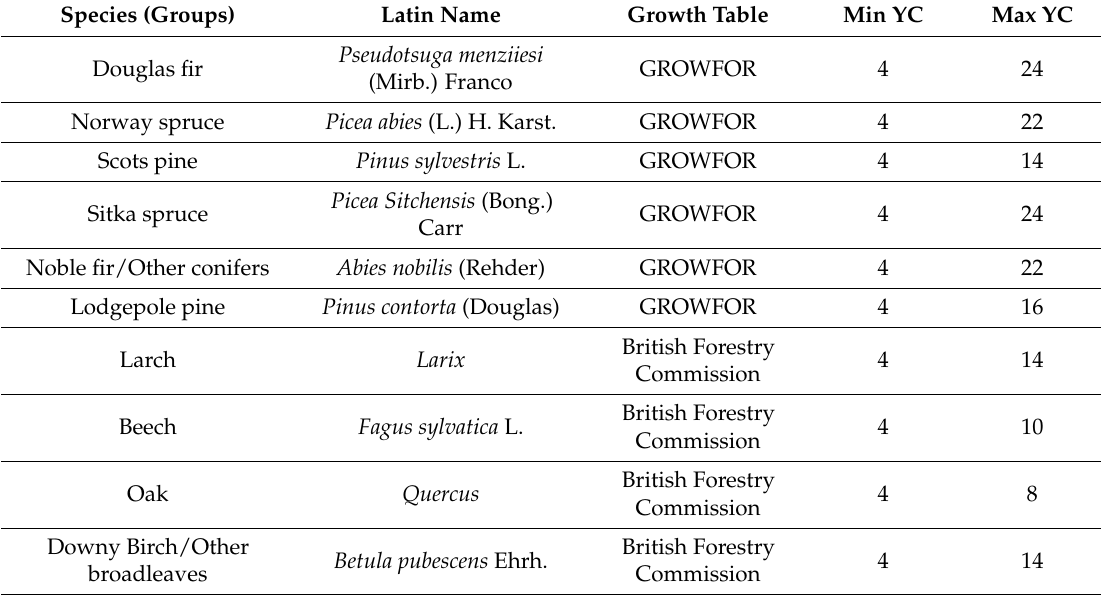
Table 3. Tree species used in the model, the origin of their growth and yield tables, and the minimum and maximum yield class (m 3 ha − 1 year − 1 ) for each species based on available growth and yield tables. Species (Groups)